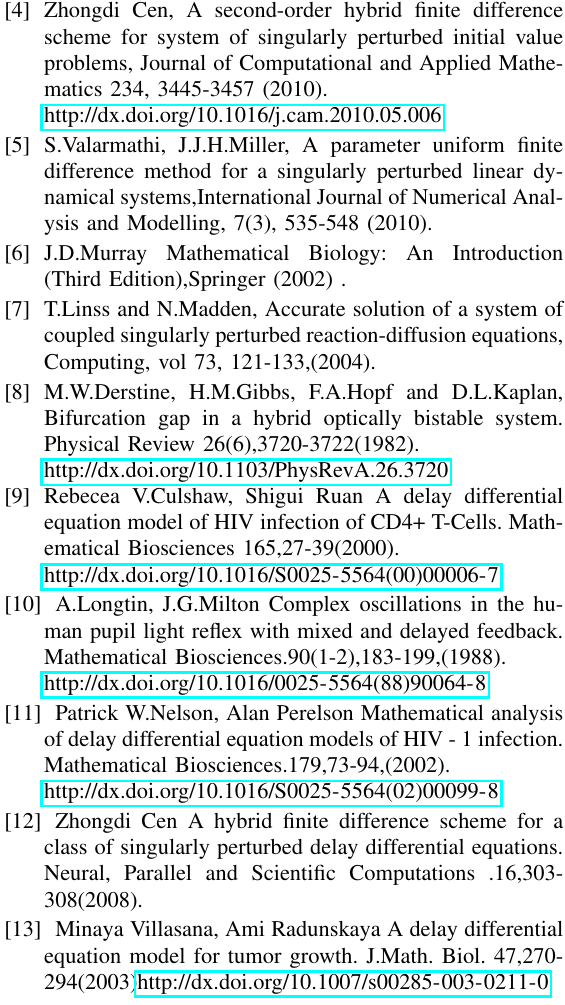
Fig. 1. Numerical